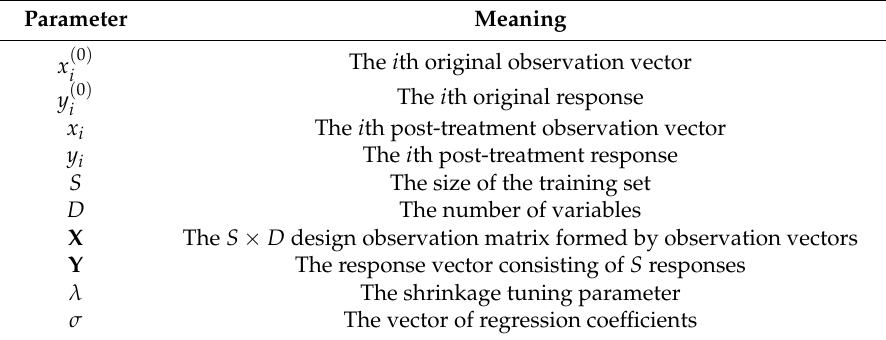
Table 1. The main parameters in Section